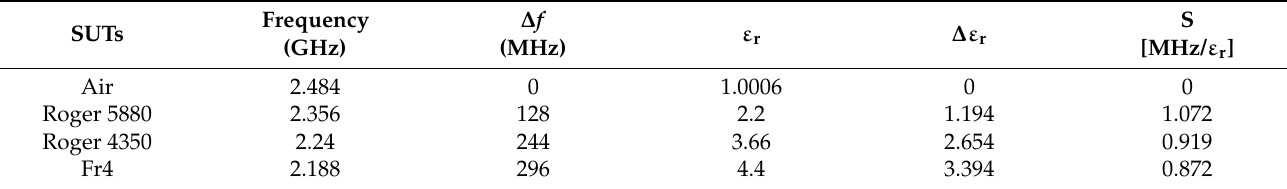
Table 9. Sensitivity of the various